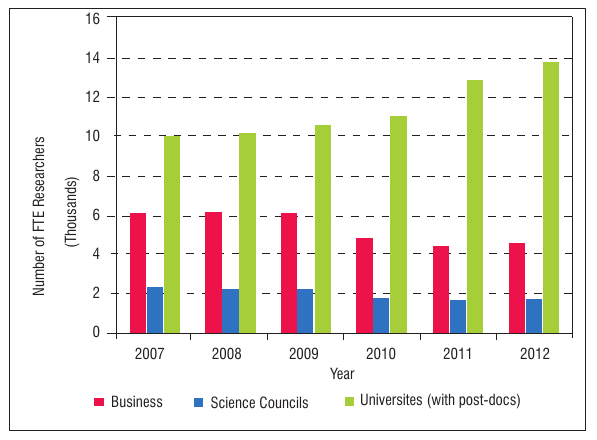
Figure 4: Trends in FTE researchers in the three R&D performance sectors (2007 to 2012).